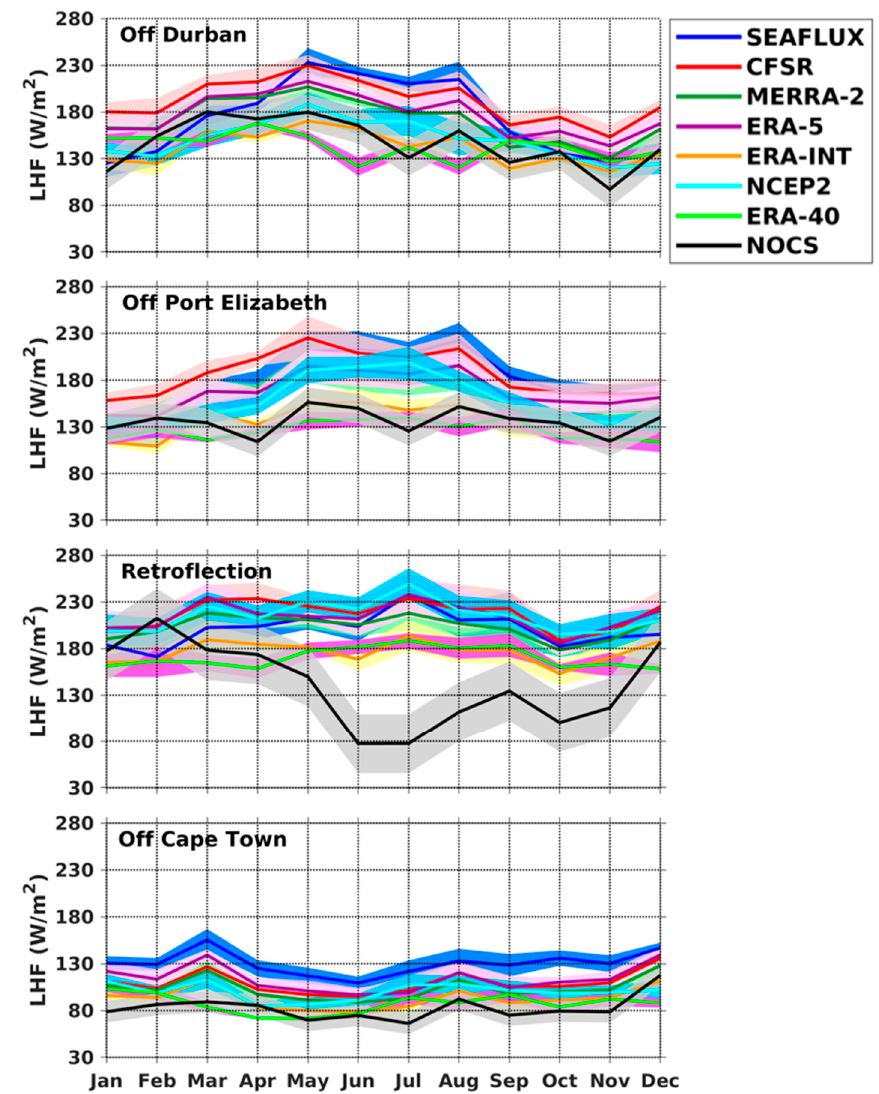
Figure 3 : Annual cycles of latent heat flux (W/m²). In Agulhas Current off Durban (31.5–32.5°E; 30–31°S), off Port Elizabeth (25–26°E ; 34.5–35.5°S), Agulhas Retroflection (19–20°E ; 38–39°S) and off Cape Town (16–17°E ; 33.5–34.5°S) for SEAFLUX (blue), CFSR (red), MERRA-2 (green), ERA-5 (purple), ERA-Interim (yellow), NCEP2 (cyan), ERA-40 (purple) and NOCS (black). Shades areas represent the standard errors calculated as the standard deviation divided by the square root of the number of years.